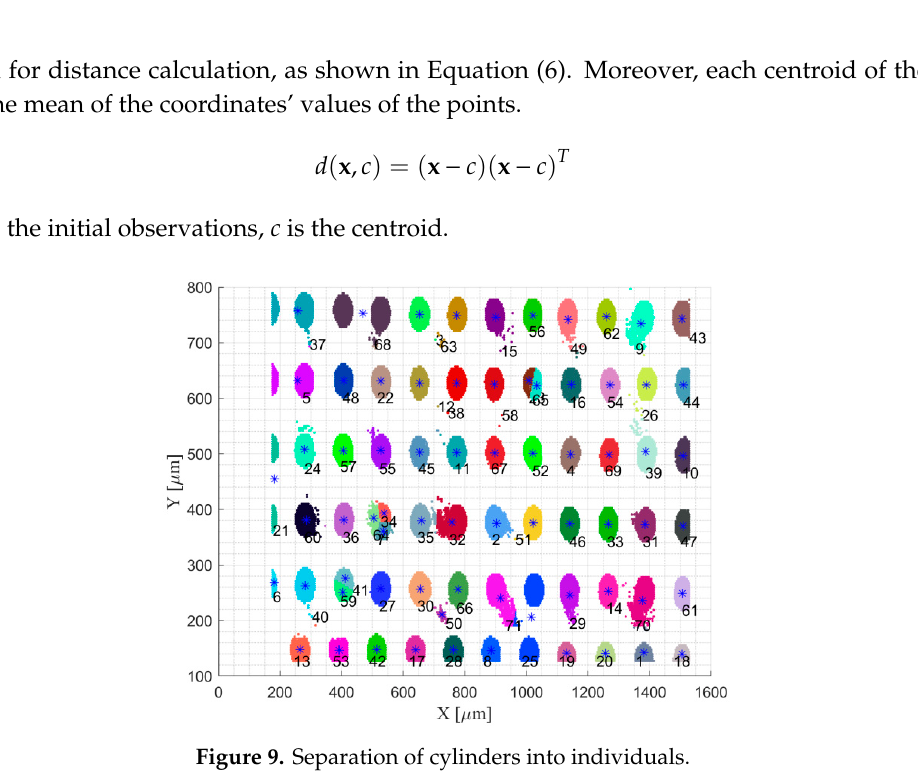
Figure 9. Separation of cylinders into individuals.